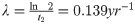
Failure curves for a conspiracy of No = 5000 over a 50 year period with exponential removal of conspirators with half-life t2 of 5 years (λ=ln 2t2=0.139yr−1) with (a) assumption of constant p (b) proportional change in probability p(t) = po eλt.